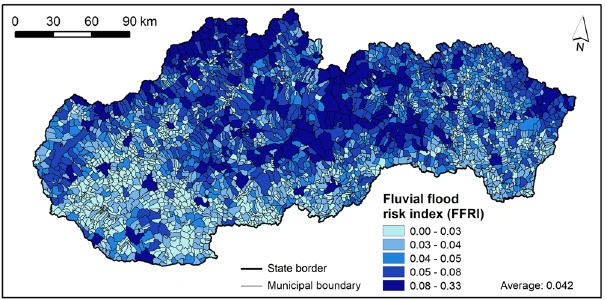
Figure 13. FFRI in municipalities of Slovakia. This figure was generated in ArcGIS 10.2.2